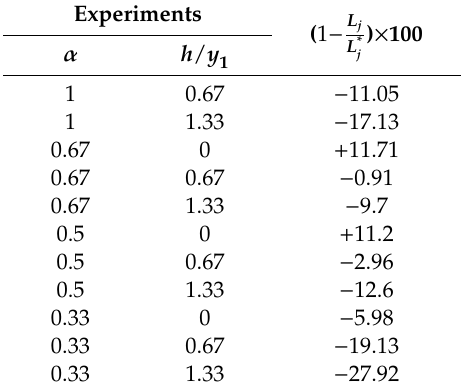
Table 3. Comparison of variations percentage of the hydraulic jump length to the classical jump.